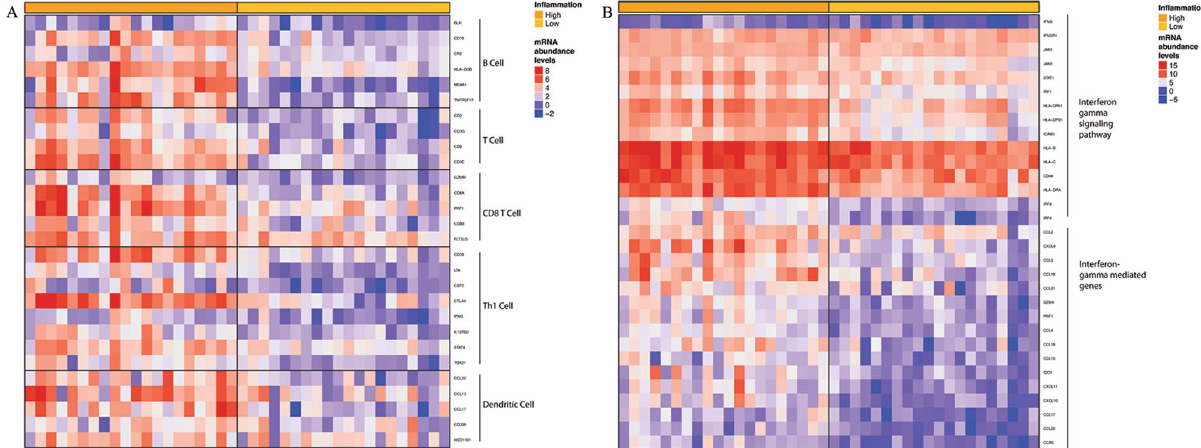
Figure 3. Expression pattern of representative genes in ( A ) immune cells. Top to bottom: B cell, T cell, CD8, Th1 and dendritic cell expression clusters as defined by the NanoString human PanCancer immune panel. ( B ) Unclustered expression levels of IFN-γ signaling pathway and downstream response genes among high- and low- invasive front inflammation muscle invasive urothelial carcinomas in the NanoString discovery